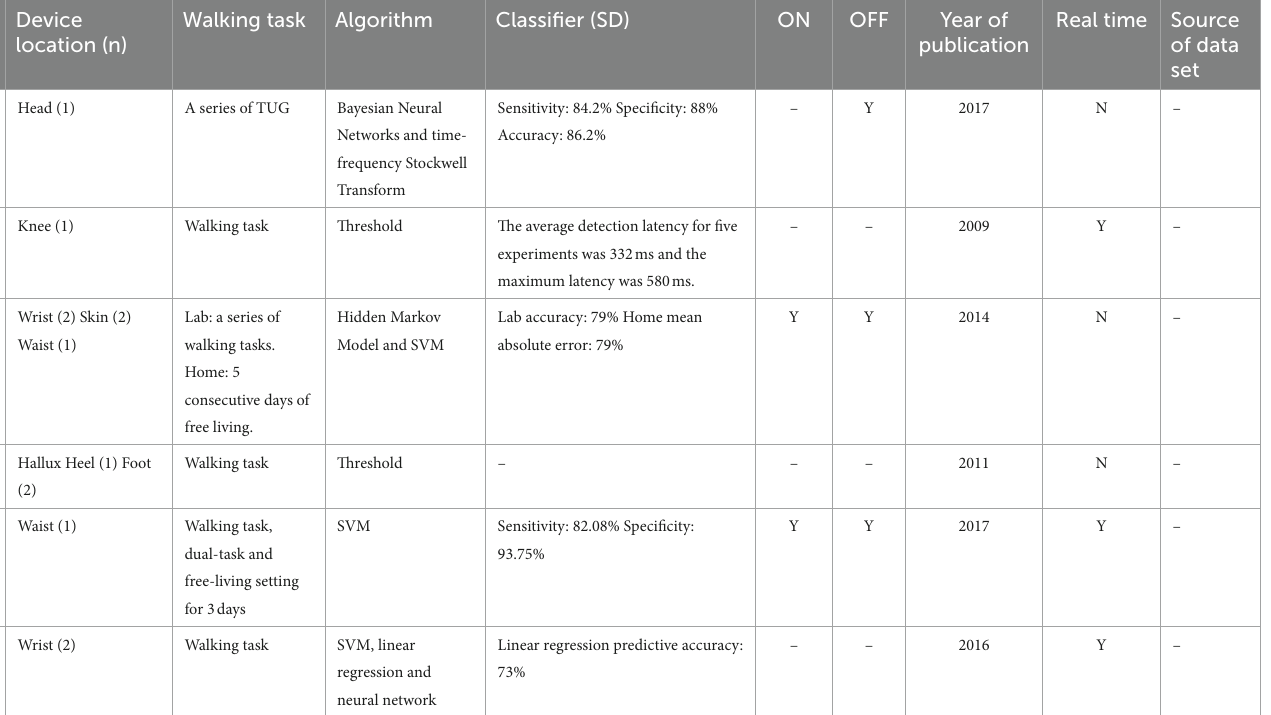
regression and neural network